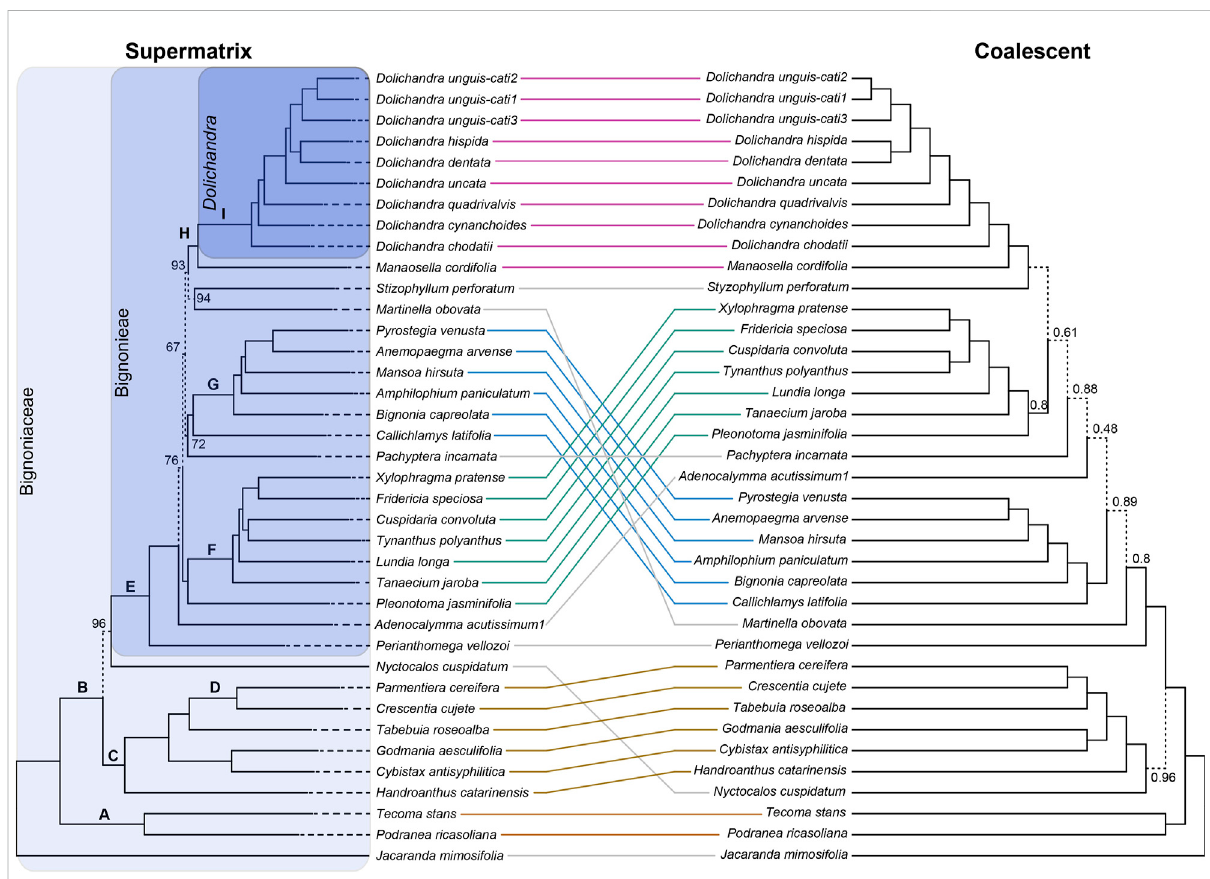
FIGURE 3 Tanglegram comparisons of phylogenies obtained using a supermatrix approach and IQ-TREE, and a coalescent approach and ASTRAL-III of the Supercontig dataset. The supermatrix result includes ultra-fast bootstrap proportion (UFBoot) support values. The coalescent result is labeled withlocalposteriorprobabilities(LPP).ValuesabovebrancheswithmaximumsupportoftheUFBootandLPParenotshown.Brancheslabeledonthe supermatrix tree are discussed in the text. Shaded boxes enclose the entire Bignoniaceae family; the tribe Bignoniaeae; and the genus Dolichandra